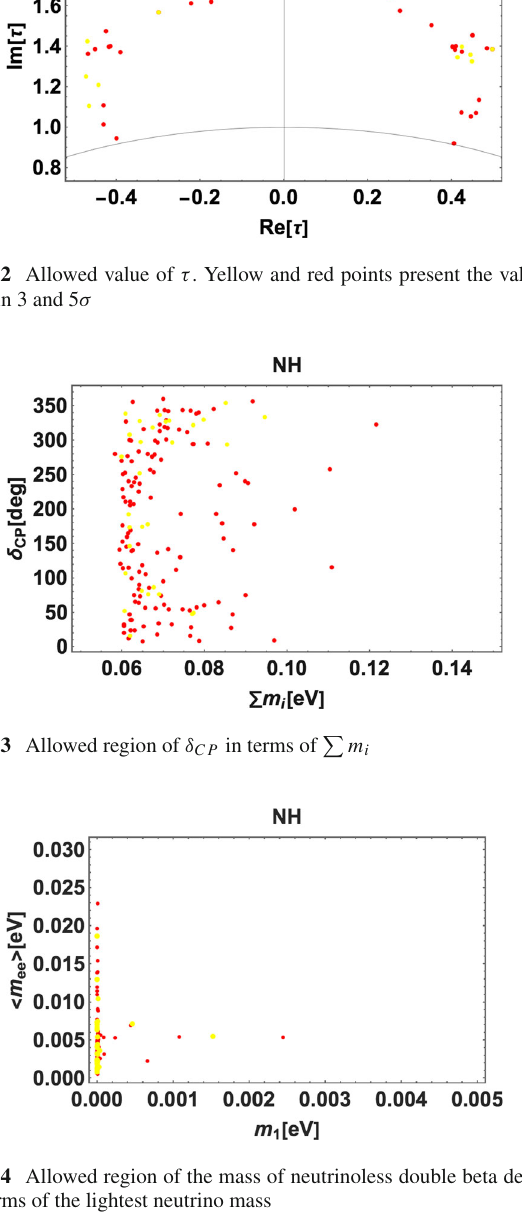
depict allowed region of Majorana phases α 21 and α 31 . Both